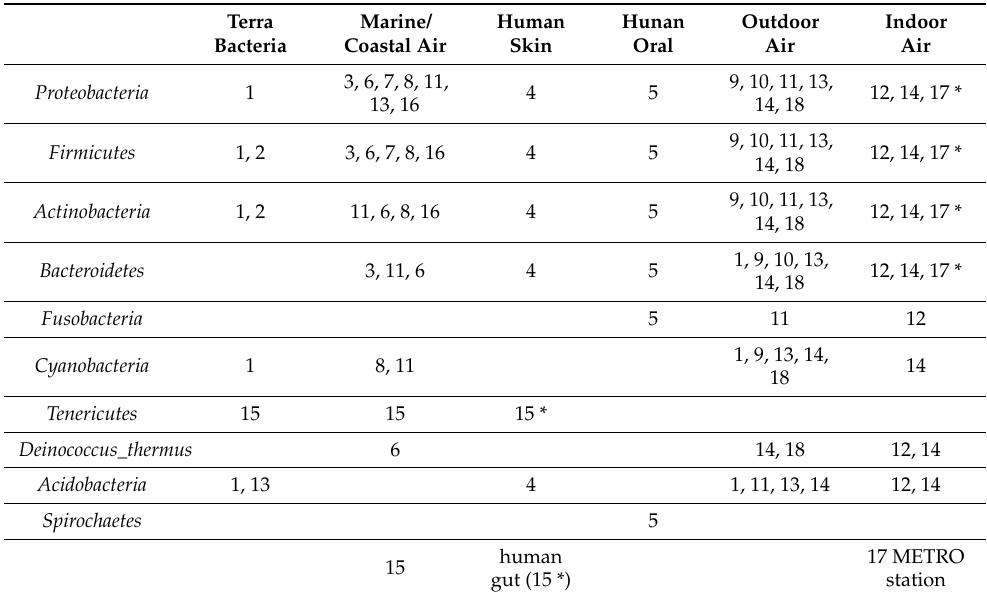
Table 2. The bacterial Phyla detected in bioaerosols of Athens and their probable sources based on literature.